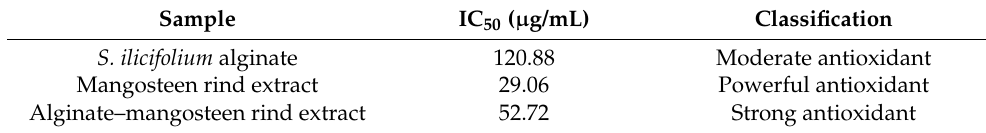
Table 1. Antioxidant activity of alginate, mangosteen rind, and alginate–mangosteen rind combination.